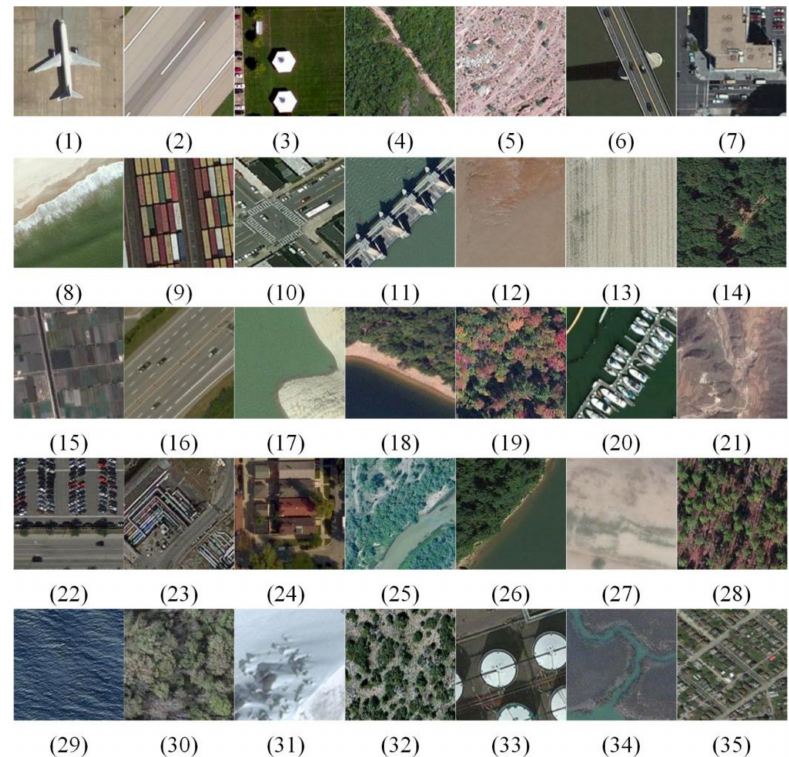
Figure 6. Sample images of each category in RSI-CB dataset: (1) airplane, (2) airport runway, (3) artificial grassland, (4) avenue, (5) bare land, (6) bridge, (7) city building, (8) coastline, (9) container, (10) crossroads, (11) dam, (12) desert, (13) dry farm, (14) forest, (15) green farmland, (16) highway, (17) hirst, (18) lake shore, (19) mangrove, (20) marina, (21) mountain, (22) parking lot, (23) pipeline, (24) residents, (25) river, (26) river protection forest, (27) sand beach, (28) sapling, (29) sea, (30) shrub wood, (31) snow mountain, (32) sparse forest, (33) storage room, (34) stream, (35)